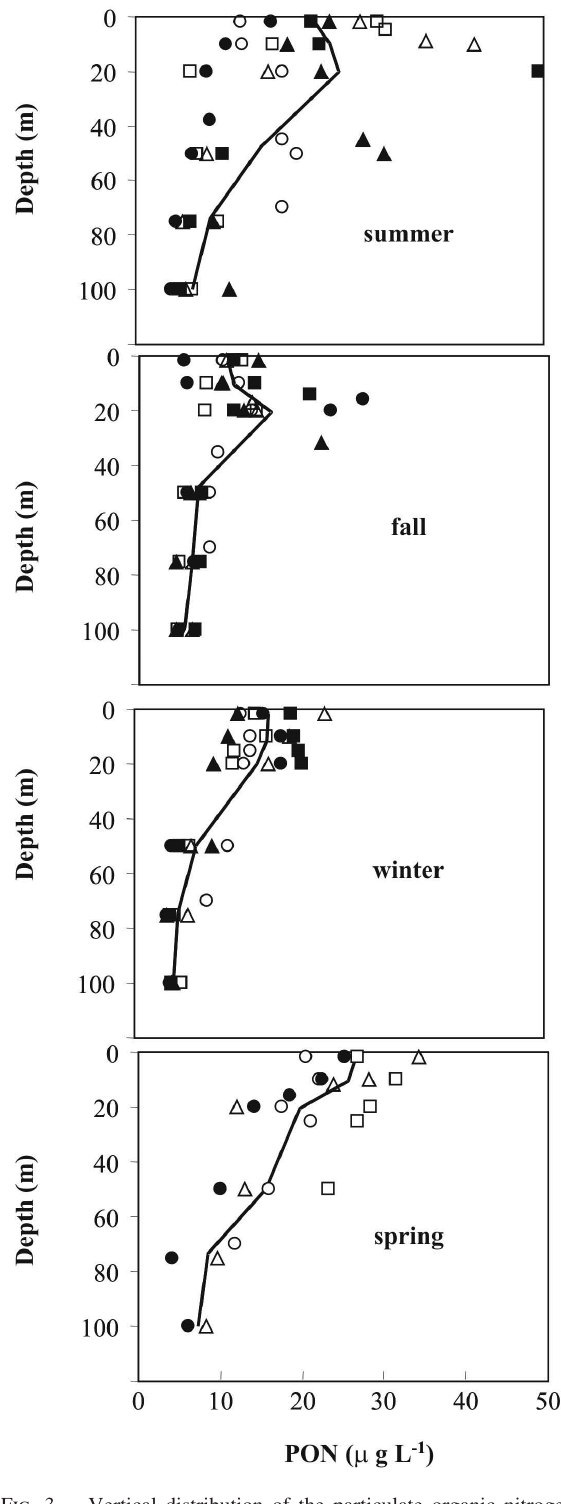
Fig . 3. – Vertical distribution of the particulate organic nitrogen concentration (PON, m g L -1 ) at the sampling stations during the four seasonal surveys (station 1: open circles; station 2: open squares; station 3: open triangles; station 4: closed circles; station 5: closed squares; station 6: closed triangles). The solid lines represent the averaged seasonal profiles.